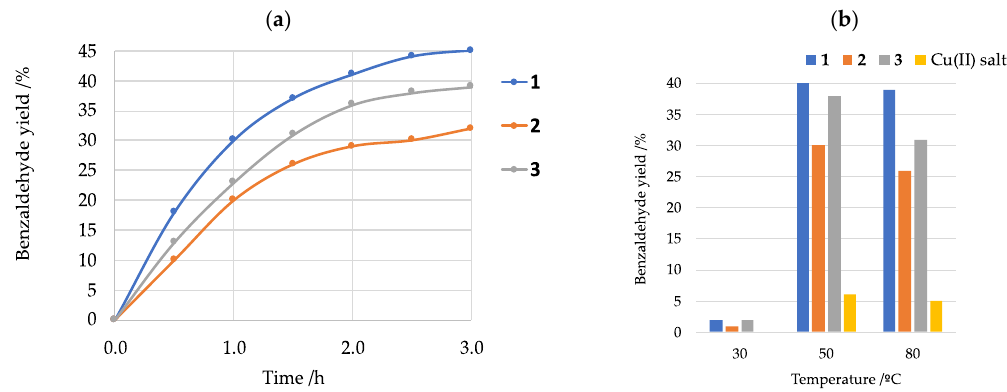
Figure 3. Effect of reaction time ( a , T = 50 ◦ C) and temperature ( b , 2.5 h) on the yields of benzaldehyde obtained by the MW-assisted oxidation of toluene catalyzed by complexes 1 – 3 .